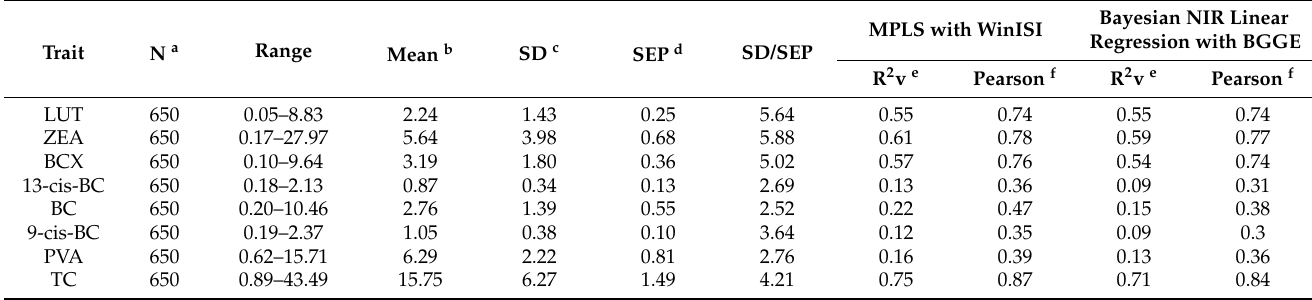
Table 2. Reference values and external validations statistics of the NIRS calibrations for carotenoid contents in maize using Bayesian NIR linear regression and MPLS methods. A total of 1857 maize lines were used as training (TRN) and 650 maize lines were used as testing (TST) (unobserved).